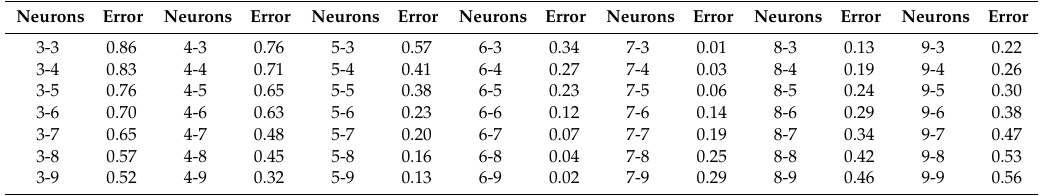
Table 1. Error of network training with di ff erent numbers of nodes in the first and second hidden layers.